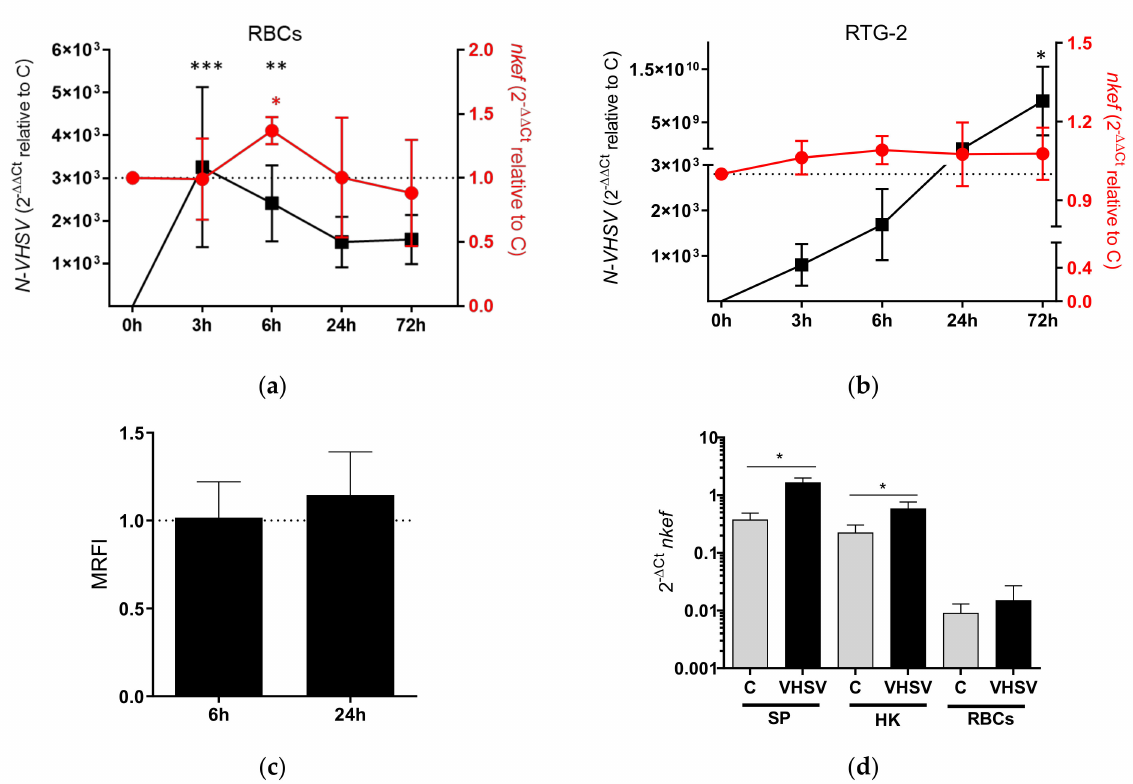
Figure 1. NKEF expression is increased in rainbow trout RBCs after VHSV exposure. Time course of nkef gene expression in ( a ) RBCs and ( b ) RTG-2 cells exposed to VHSV at a multiplicity of infection (MOI) of 1 at different time points post-exposure. The graph shows the RT-qPCR gene expression profiles for nkef in red and the N-VHSV gene in black. Gene expression was normalized to control cells (C, unexposed to virus), dashed line. The endogenous gene control used was om-ef1 α . h indicates hours. Data represent the mean ± SD of n = 6 individuals for RBCs and n = 3 experiments in RTG-2. For statistical analysis, the Kruskal–Wallis test and Dunn’s multiple comparison post hoc test were performed. *, **, and *** indicate p -values < 0.05, <0.01 and <0.001, respectively, for the N-VHSV gene (black asterisks) and for nkef (red asterisk), and normalized to control cells (unexposed to virus) at each respective time point. ( c ) NKEF protein expression in VHSV-exposed RBCs at 6 and 24 hpe analyzed by flow cytometry. Mean relative fluorescent intensity (MRFI), relative to control cells (dashed line) is represented in the graph. h indicates hours. Data show the mean ± SD of n = 7 individuals. The Kruskal–Wallis test and Dunn’s multiple comparison post hoc tests were performed and compared with the control. ( d ) nkef gene expression in different tissues (spleen [SP], head kidney [HK] and RBCs) from rainbow trout challenged with VHSV at 48 h post-challenge. RT-qPCR was used to analyze data. Om-ef1 α was used as reference gene. C means mock-infected rainbow trout. Data represent the mean ± SD of n = 2 individuals. Mann–Whitney analysis was used for statistical analysis. * indicates p -value <